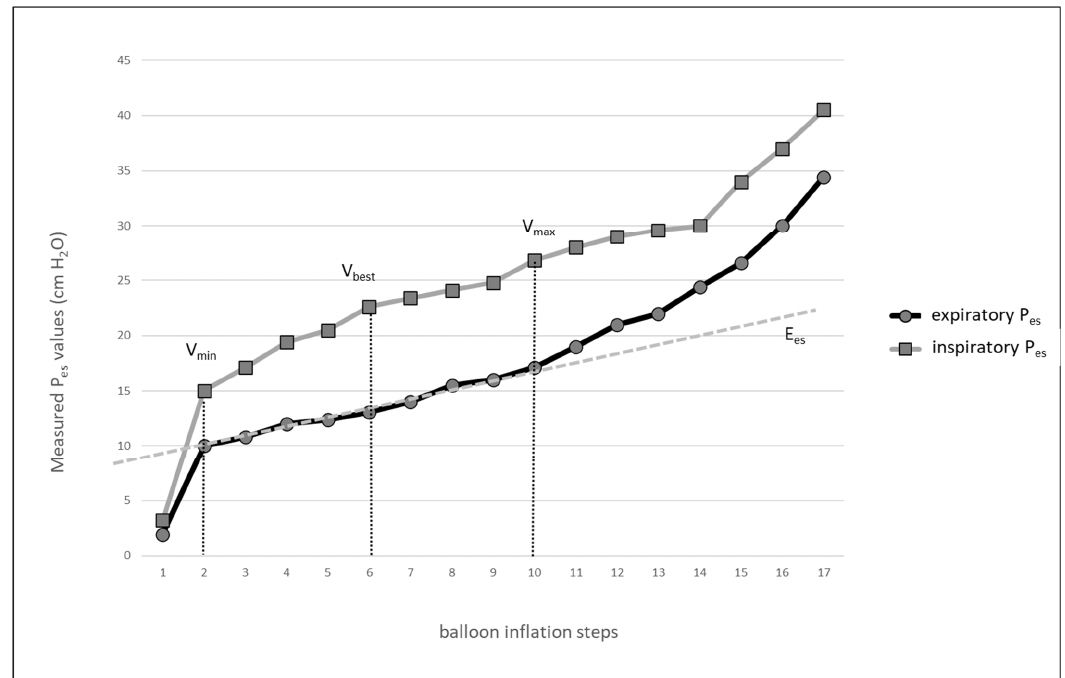
Figure 1. An example of the balloon pressure-volume curve obtained in an obese patient with influ- enza A pneumonia and congestive heart failure. Inflation steps are shown on x axis. E es —esophageal elastance ; V min — volume of the balloon at the beginning of the linear part of balloon pressure- volume curve; V max —volume of the balloon at the end of the linear part of balloon pressure- volume curve; V best —lowest volume of the balloon with largest tidal difference of esophageal pres- sure; P es —esophageal pressure. To compensate for the baseline changes of P es at higher inflation volumes, it was sug- gested to subtract from the measured value of P es the pressure generated by the distension of the esophageal wall—esophageal recoil pressure (P ew ). This pressure can be calculated from the elastance of the linear part of the pressure-volume curve of the balloon: P ew = (V best − V min ) × E es , where V best in mL is the balloon volume with the largest tidal swing of P es ,V min in mL is the minimum filling volume of the balloon at the beginning of the linear part of the balloon pressure-volume curve (Figure 2), and E es in cm H 2 O/mL is calculated using the least square fitting method from Pes values [15,16]. E es can also be estimated using a simplified method based on the P es values obtained at V min and V max [17]. Using this approach, E es is calculated as the difference in P es at V max and V min divided by the dif- ference between V max and V min , and calibrated P es is calculated as the difference between the measured P es at V best and P ew at V best (Table 2, Figure 2). All calculations can be done using an appropriate table calculator.